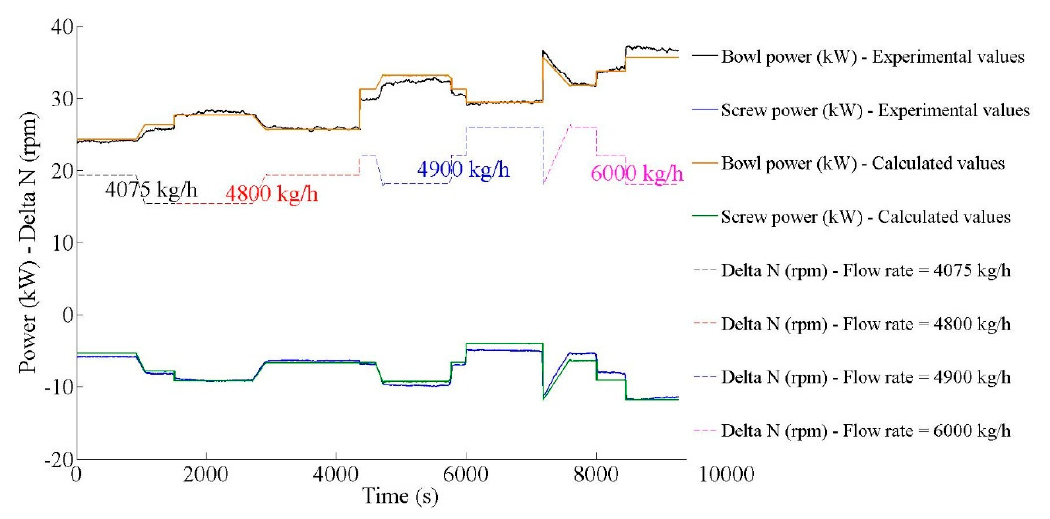
Figure 4. “Two-fit” case plot: calculated values corresponding to each harvesting season are obtained using separate experimental values acquired during two harvesting seasons.